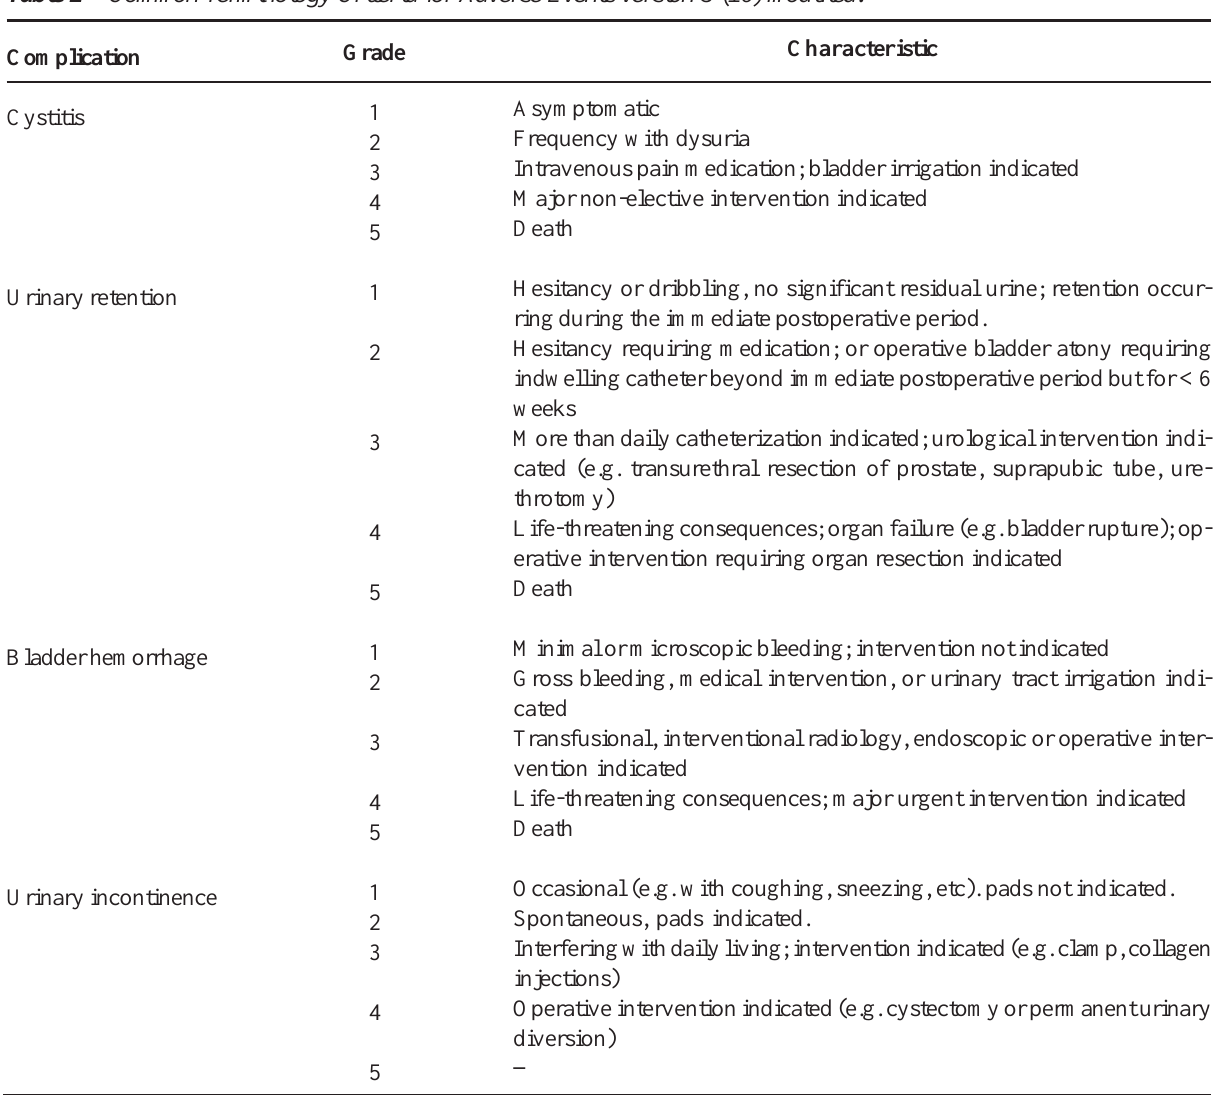
Table 1 – Common Terminology Criteria for Adverse Events version 3 (10)